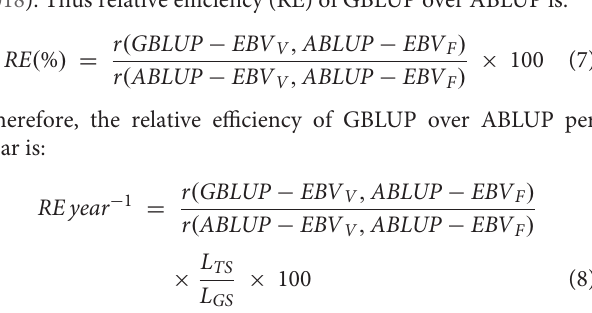
TABLE 1 | Number of observations ( N ), mean standard deviation (SD), minimum (Min), maximum (Max), and coefficient of variation (CV%) for the measured growth and drought-tolerance traits before, during and after water stress in Pinus radiata